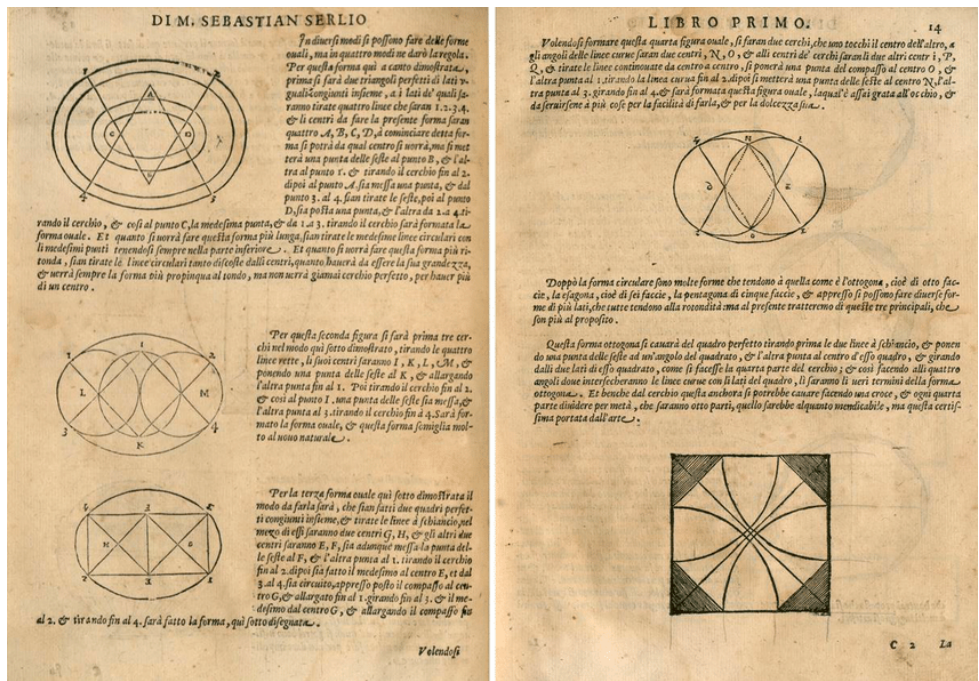
Figure 7. Throughout history, methods for drawing and constructing an oval shape have undergone